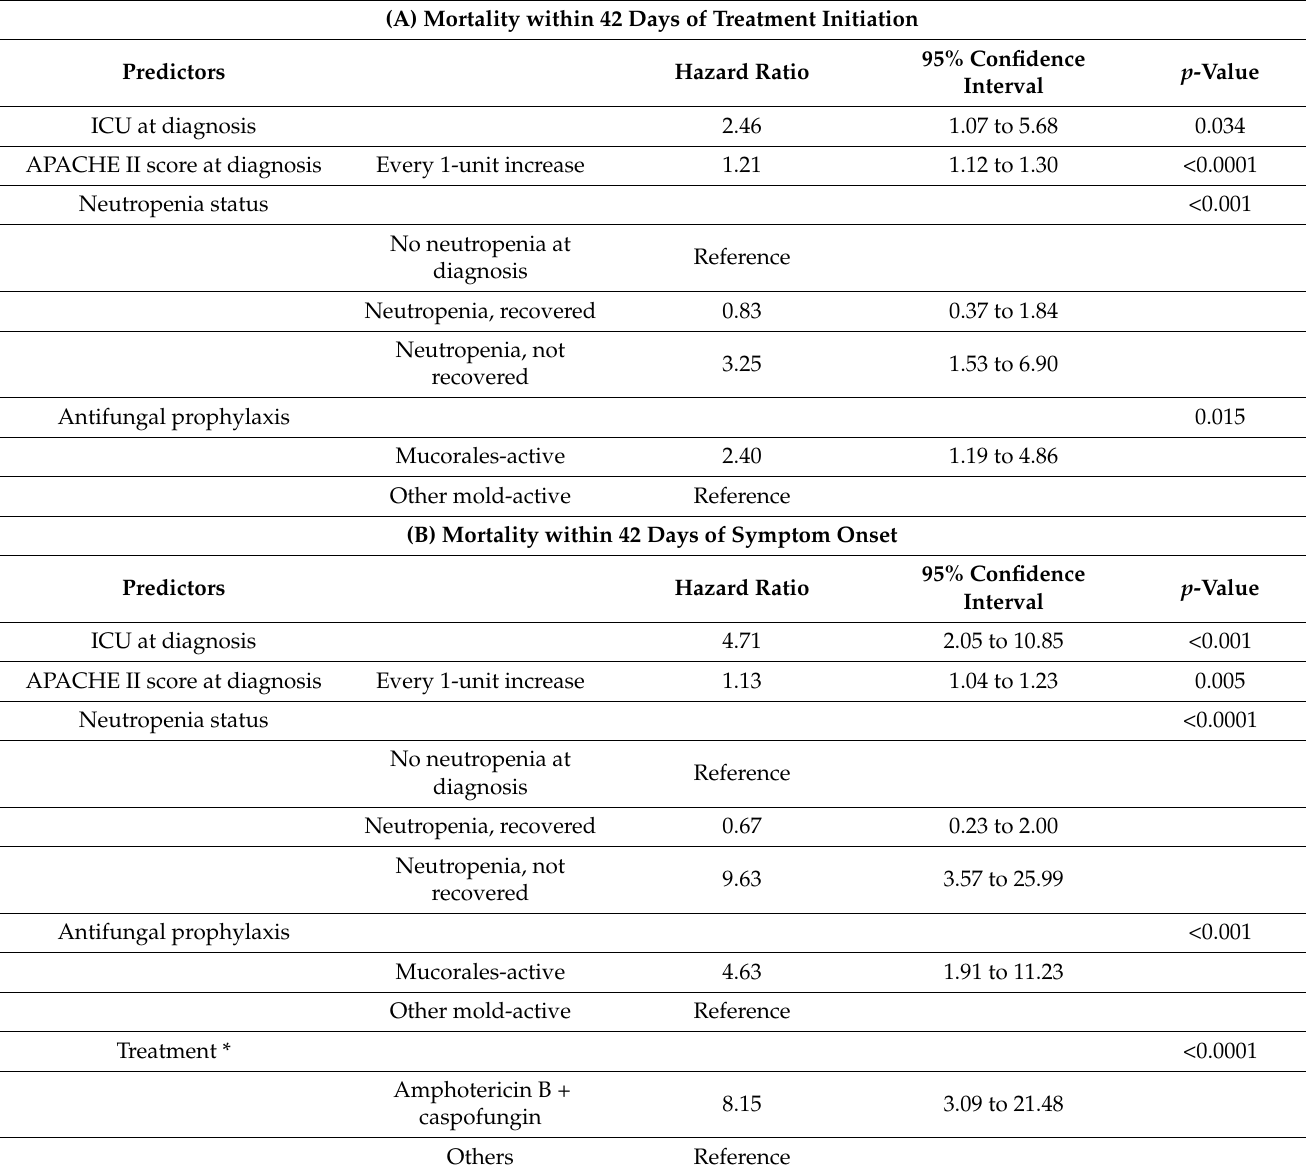
Table 4. Cox regression model of independent predictors of 42-day mortality in patients with